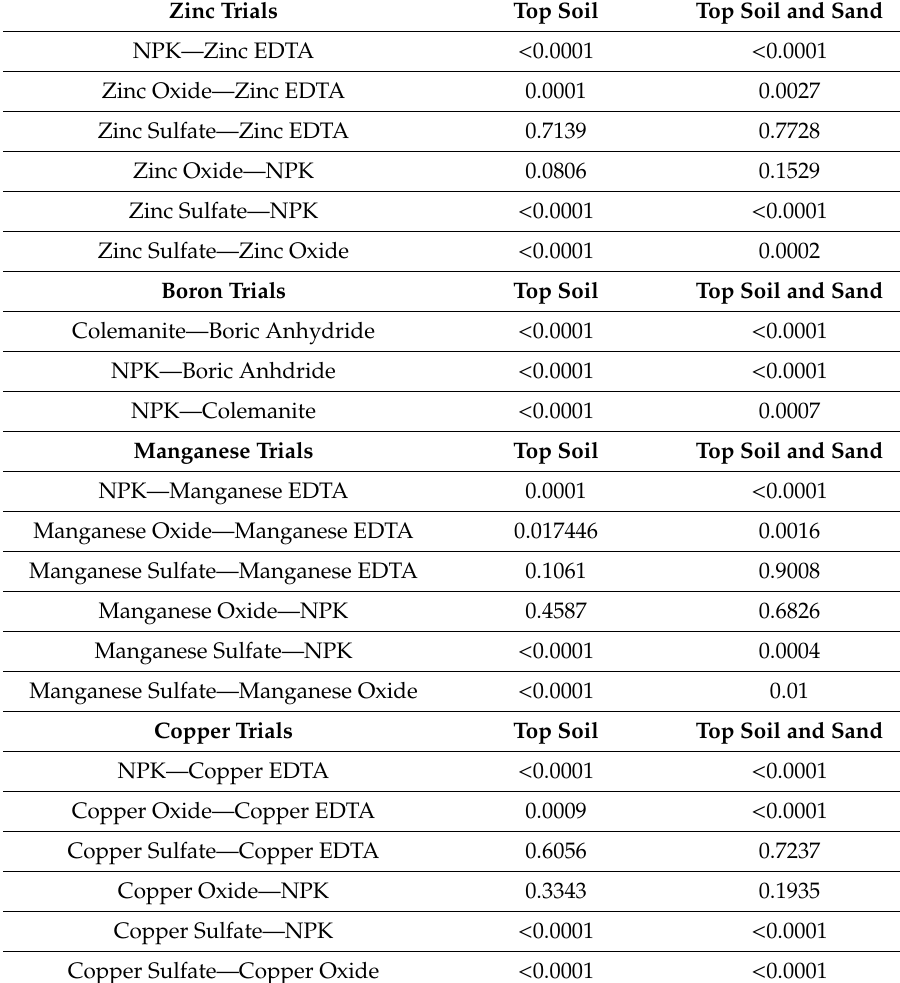
Table 5. Comparison of raw materials for the di ff erent micronutrients tested in two di ff erent media, using a one-way ANOVA statistical analyses and post hoc Tukey multiple comparisons of means. Zinc Trials Top